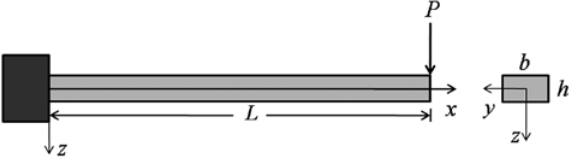
Figure 2: Schematic diagram of the rectangular cantilever gradient piezoelectric